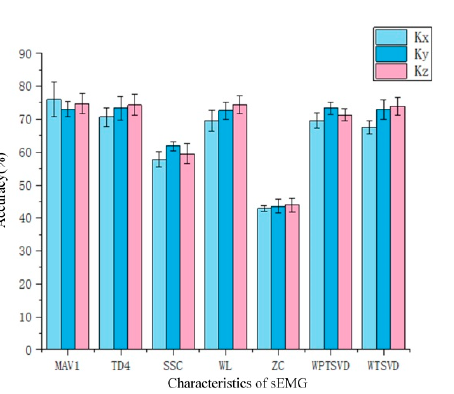
Table 2. Hyper parameters of XGBoost (Kx, Ky, Kz).